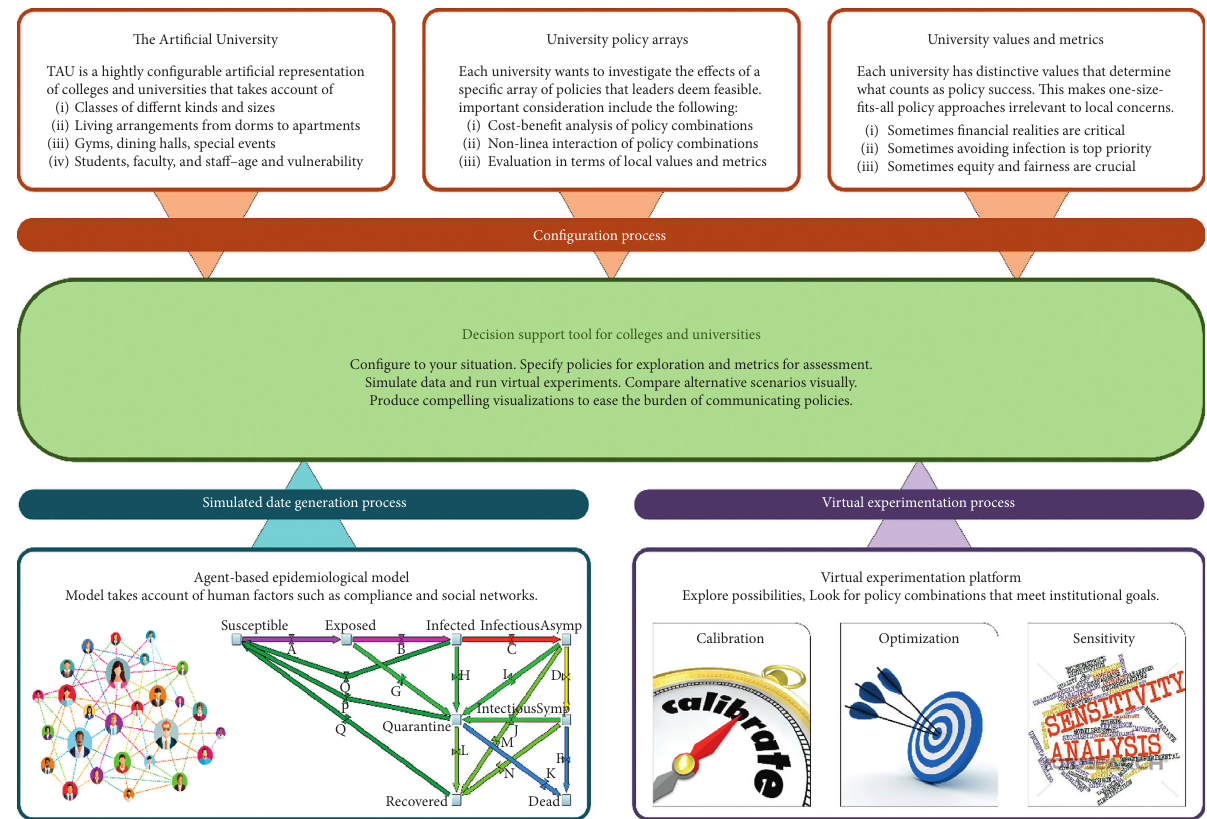
Figure 1: Diagram of TAU, a decision support tool for colleges and universities. The threefold configuration process is at the top, the simulation and social network feeding TAU is at the bottom left, and the virtual experimental platform is at the bottom